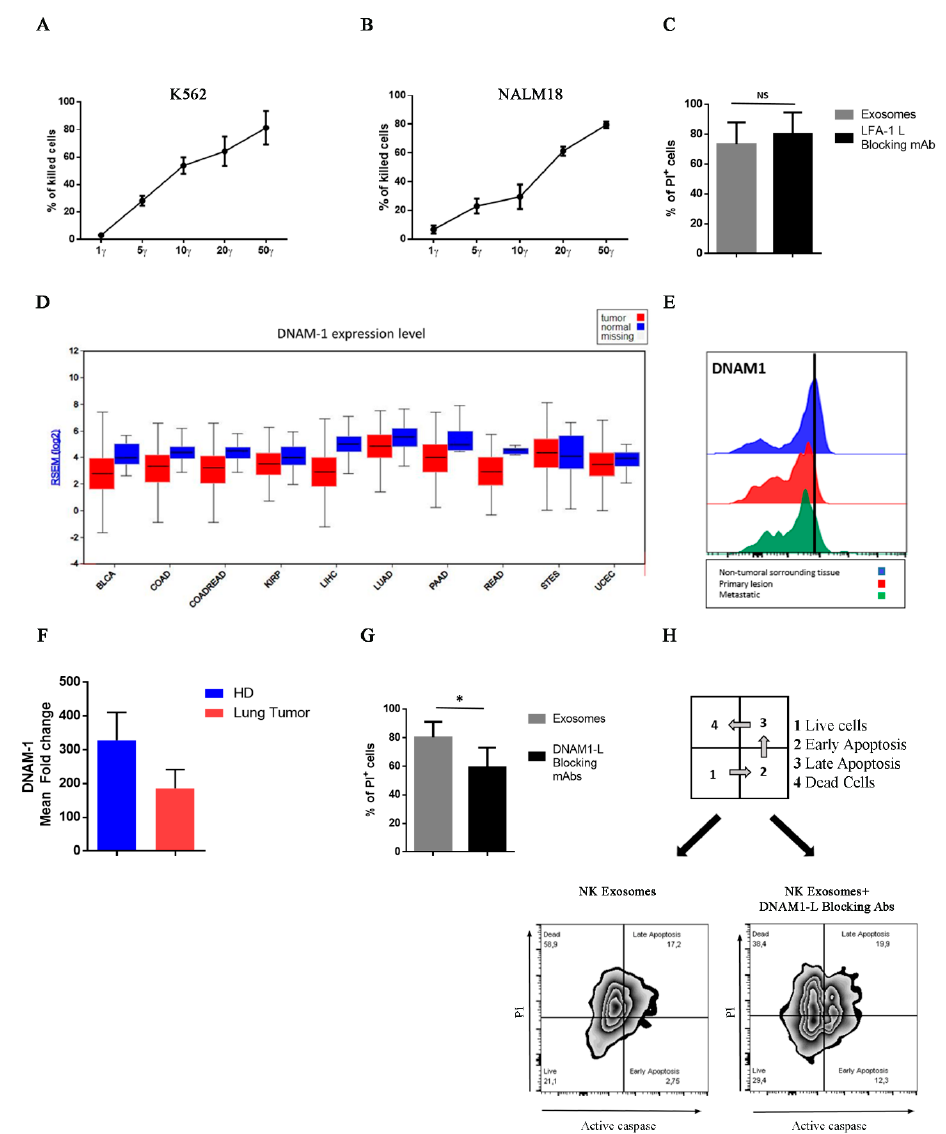
Figure 4. Cytotoxicity and molecular mechanisms involved in killing of K562 and NALM-18 tumor cell lines by NK-derived exosomes. ( A , B ) Cytotoxic assay on K562 ( A ) and NALM-18 ( B ) target cells incubated with different doses of NK-derived exosomes (1 γ , 5 γ , 10 γ , 20 γ , and 50 γ ). The percentage of PI + cells was evaluated after 24 h of incubation with NK-exosomes. Mean ± SEM (Standard error of mean) of four independent experiments is shown. ( C ) Cytotoxic assay on NALM-18 cells treated for 24 h with 20 γ of NK-derived exosomes in the absence (grey bars) or in the presence (black bars) of blocking antibodies to LFA1 ligand (CD54) ( n = 4). Mean ± SEM is shown (ns = not significant). ( D ) Gene expression analysis in different tumors (red boxes) and healthy controls (blue boxes). TGCA datasets have been used for this analysis. For tumor abbreviations, see Table S1. ( E ) Analysis of DNAM1 in lung tumor biopsy and metastatic lesions by flow-cytometry. DNAM1 expression on infiltrating NK cell of primary tumor (red profile) and derived metastatic lesion (green profile) compared to those of surrounding normal tissue. One representative experiment is shown. ( F ) Analysis of DNAM1 expression in NK cells present in peripheral blood of lung cancer patients ( n = 3) as compared to peripheral blood mononuclear cells (PBMC) from healthy donors ( n = 4) by flow-cytometry. Mean fold change ± SEM is shown. ( G ) Cytotoxic assay on NALM-18 cells incubated with 20 γ of NK exosomes in absence (grey bars) or presence (black bar) of DNAM1 ligands (CD155 + CD112) blocking antibodies ( n = 6) (* = p -value < 0.05). ( H ) Detection of active caspase in NALM-18 cells incubated with NK exosomes in the absence or in the presence of DNAM1-ligands blocking antibodies ( n =